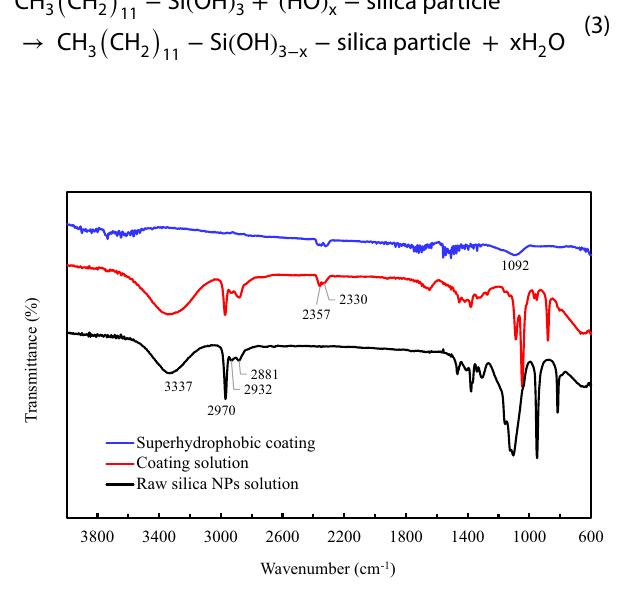
Fig. 11 a low magnification and ( b ) high magnification SEM images of the superhy- drophobic coating sprayed from the coating solution with the addition of 10 wt% PAA on the stainless steel sub- strate (SUS304). White arrows indicate the network channels with width of about 1